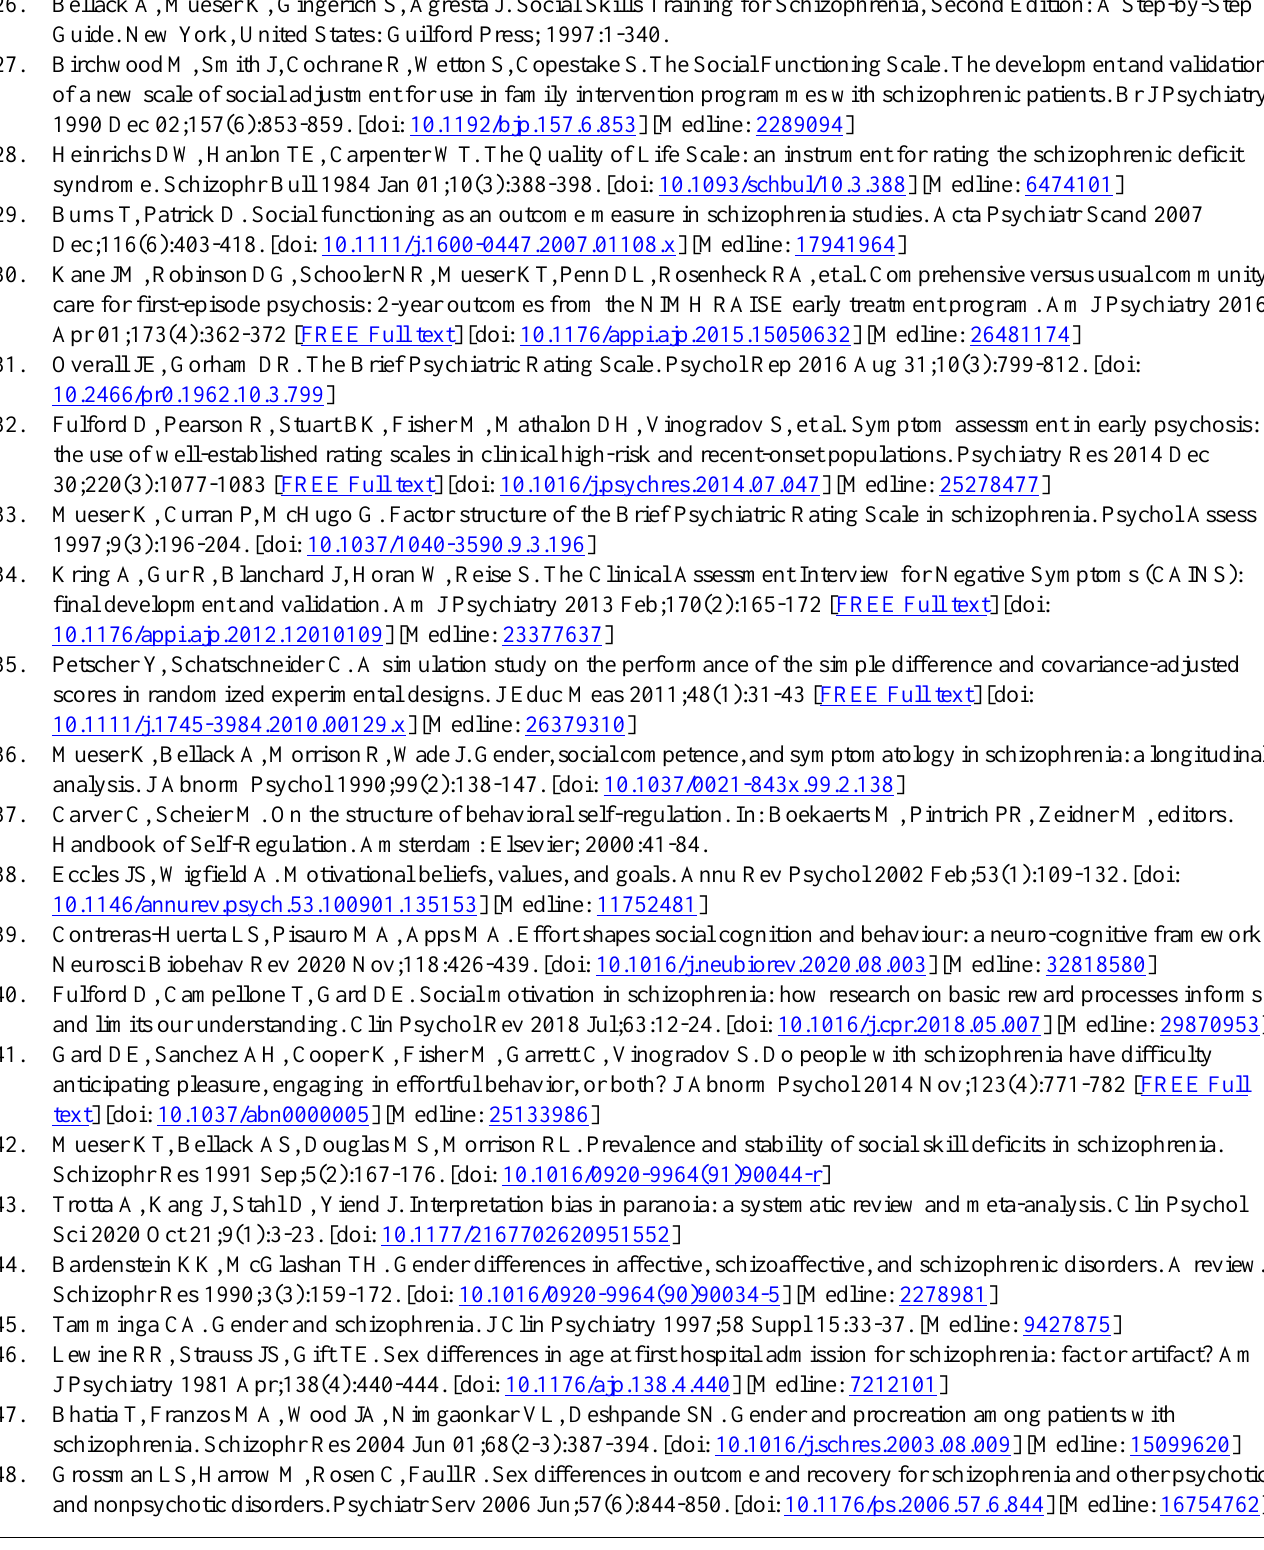
CAINS: Clinical Assessment Interview for Negative Symptoms CBTp: cognitive behavioral therapy for